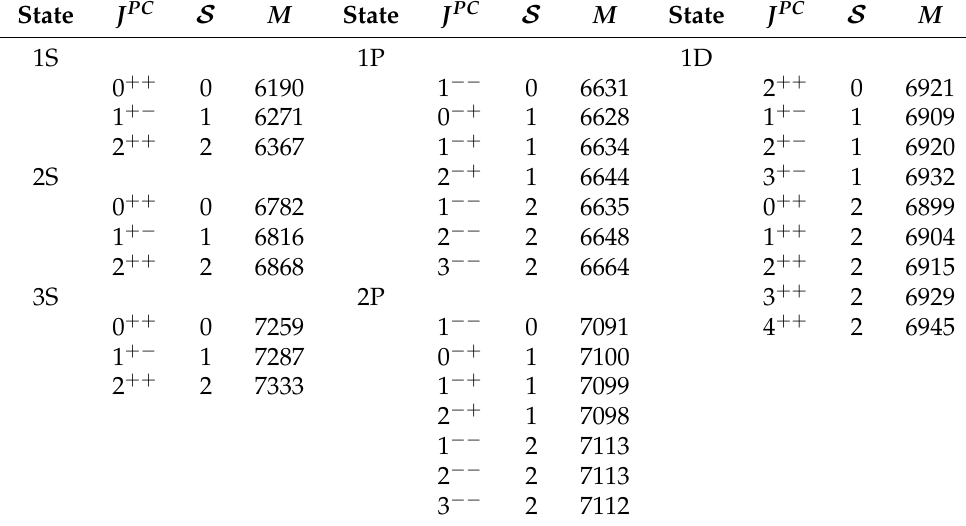
Table 12. Masses M of cc ¯ c ¯ c tetraquarks (in MeV); S is the total spin of the diquark and